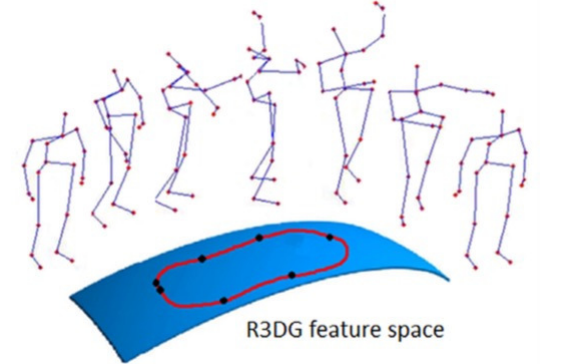
Figure 13. An action trajectory in R3DGfeature space. One point on the action trajectory is an R3DG feature of a pose [103]. Reprinted from Comput. Vis. Image Underst., Vol. 152, R. Vemulapalli, F. Arrate, and R. Chellappa, R3DG features: Relative 3D geometry-based skeletal representations for human action recognition, 155–166, Copyright 2016, with permission from